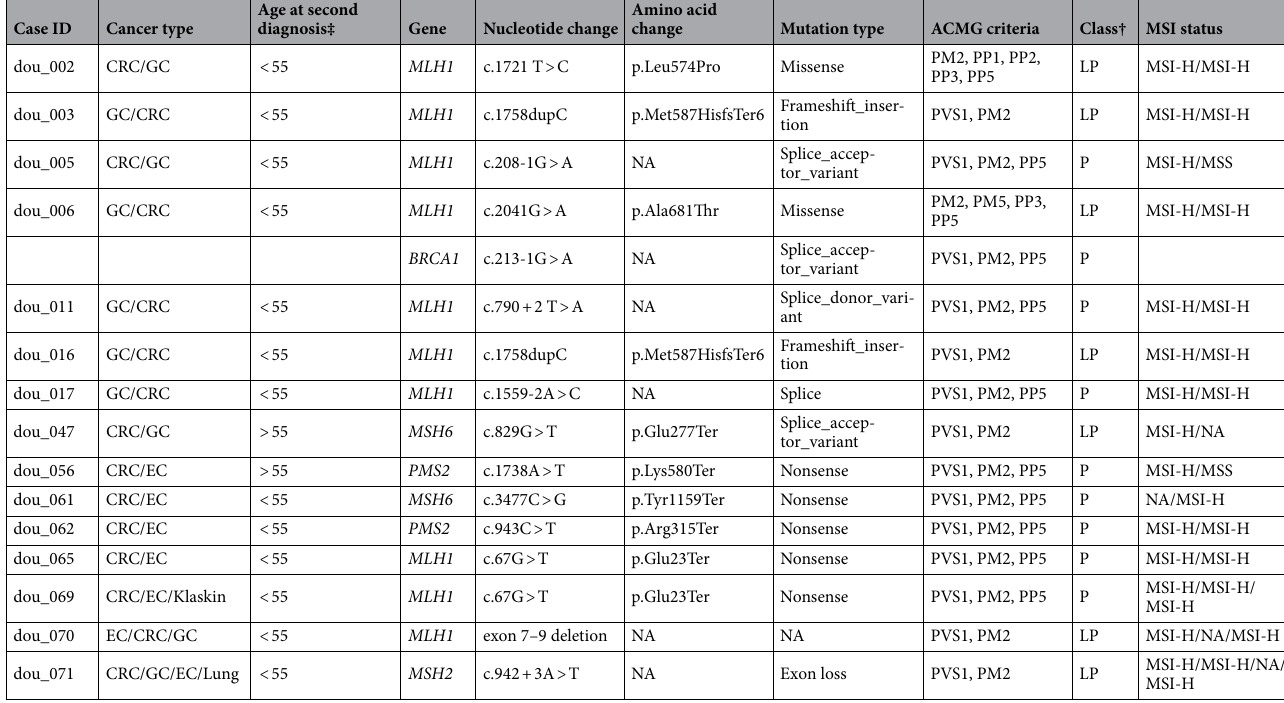
Table 1. Summary of clinicopathologic characteristics of patients with multiple Lynch related primary cancers with pathogenic/likely-pathogenic germline variants by targeted panel. *The order of MSI/MMR status is matched to cancer type. † LP: likely pathogenic, P: Pathogenic. ‡ The age of the patients is described as a range